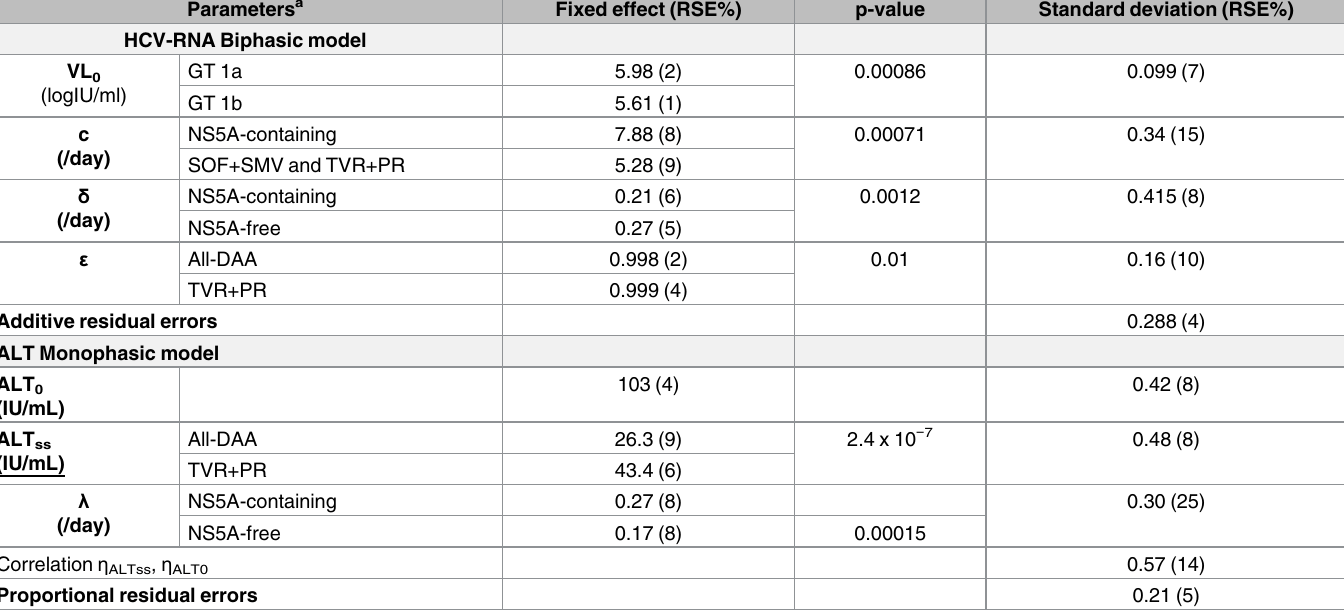
Table 2. Population kinetic parametersfor the best HCV and ALT kinetic model. Parameters a Fixed effect (RSE%) p-value Standard deviation